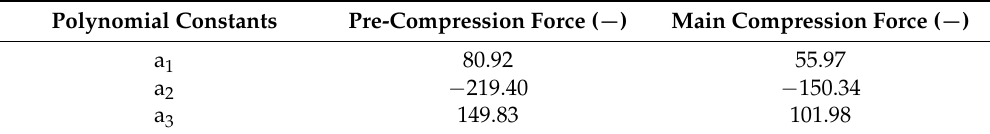
Table 3. Polynomial